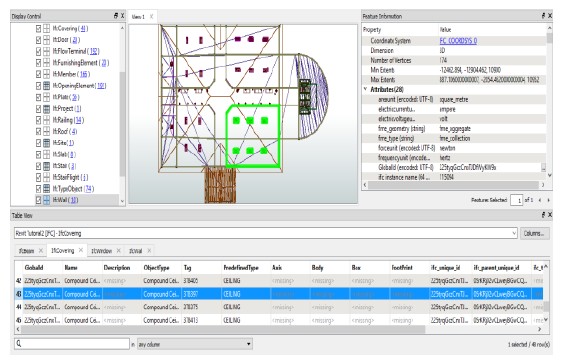
Figure 8. BIM model in FME (IFC format).